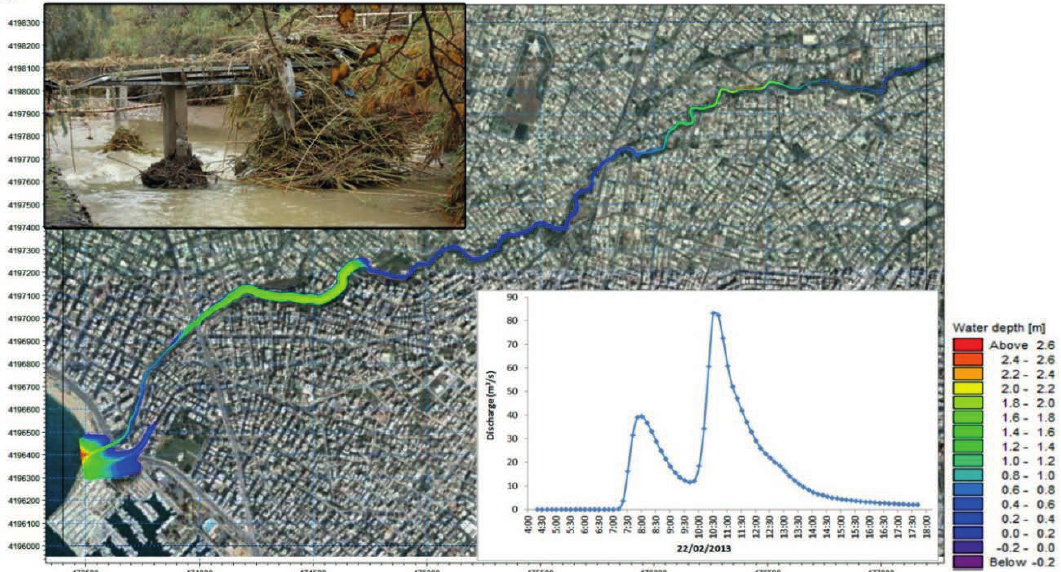
Fig. 1 Maximum water depth of the flood wave and flood hydrograph on 22 February